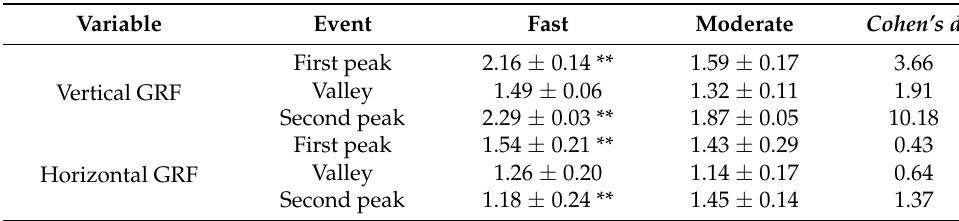
Table 3. Vertical and horizontal GRF data (BW).